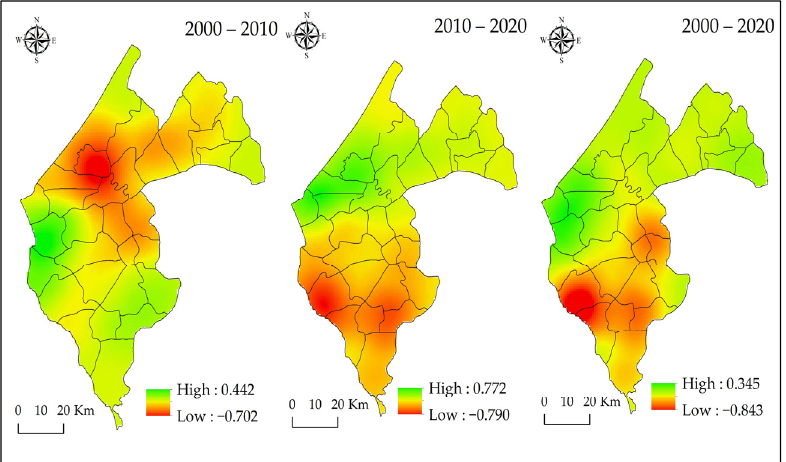
Figure 3. Spatial nuclear density of agricultural land use net transition in the Thiès region, 2000–2020.